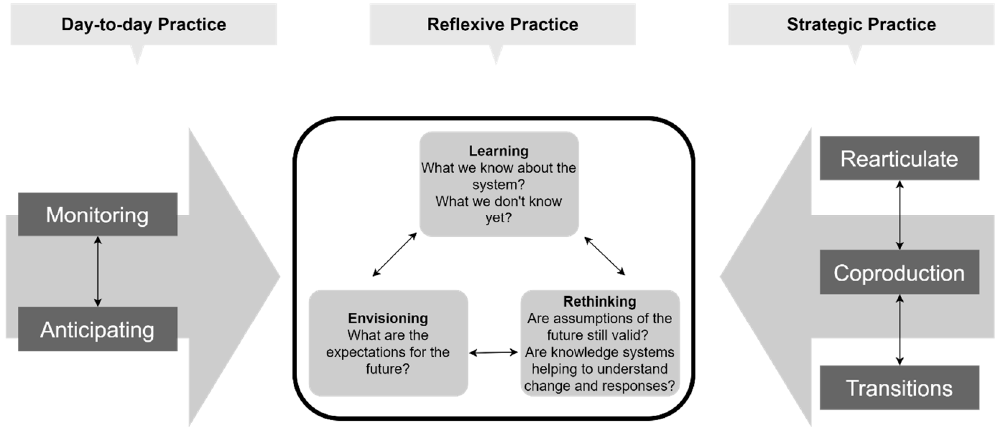
Figure 1. A framework to address multi-dimensional knowledge-based processes for management of protected areas. The day-to-day practice on the left focuses on monitoring social-ecological processes and anticipating or thinking about future conditions of the system. The reflexive practice (center) emphasizes learning from previous knowledge-based processes, rethinking assumptions and knowledge systems, and envisioning expectations. To the right, the strategic practice level focuses on how to rearticulate or transition to alternative forms of knowledge and management. Modified from Dryzek and Pickering [56].